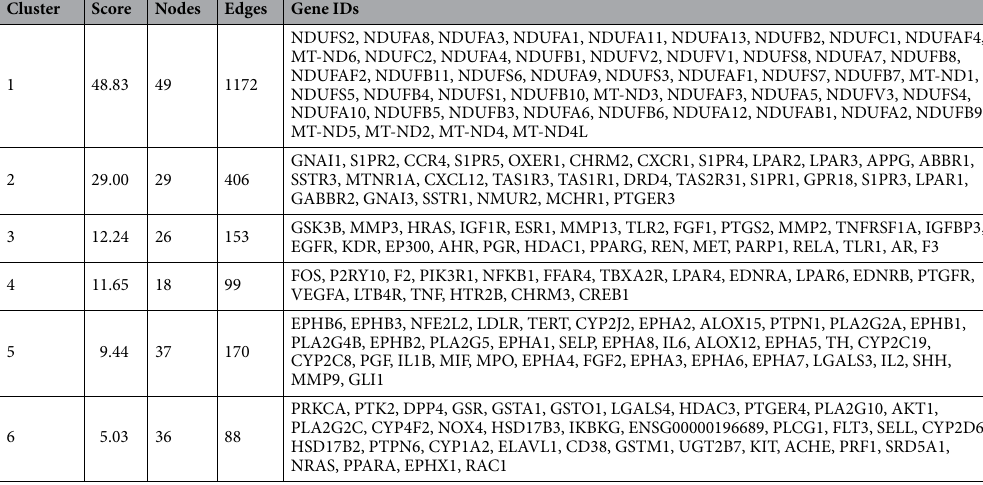
Table 3. Clusters of the predicted target PPI